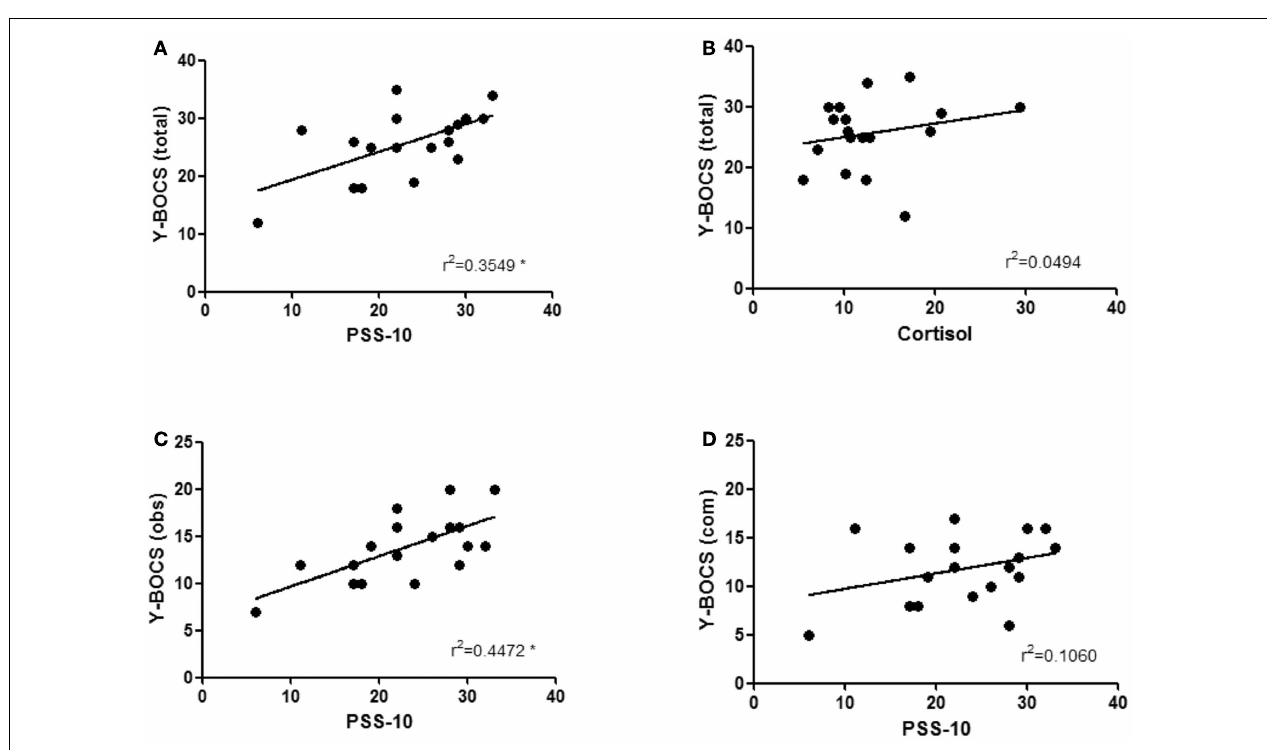
dimension of theY–BOCS scale separately, there is a positive correlation between perceived stress and the obsessive score (C) but not with the compulsive score (D) * p <